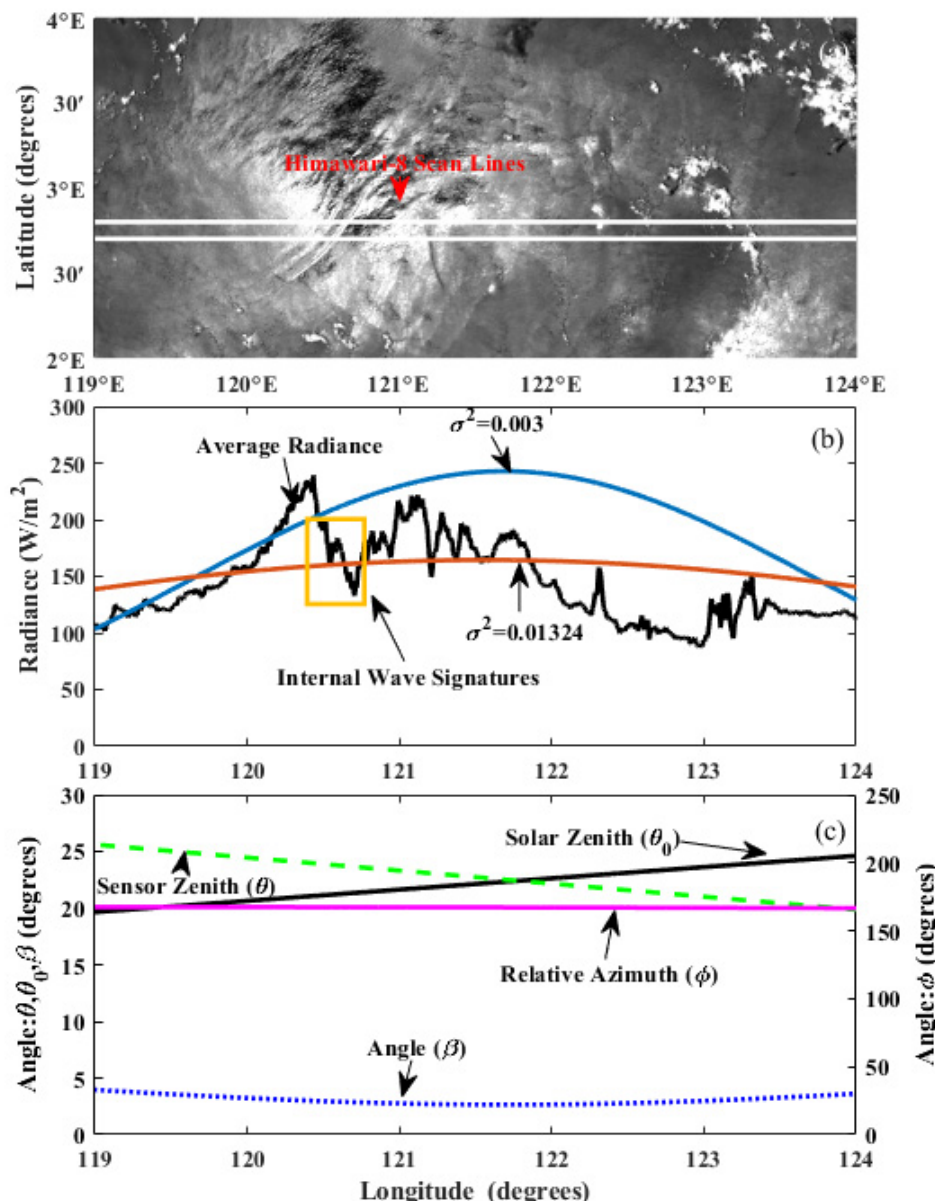
Figure 9. Analysis of the image acquired on 21 September 2020 at 05:10 UTC. ( a ) shows part of the Himawari-8 image of the Celebes Sea acquired on 21 September 2020 at 05:10 UTC, and the white solid line is the scan line of the AHI sensor onboard the Himawari-8 satellite; ( b ) shows curves of the normalized solar radiance calculated with roughness variance ( σ 2 ) values of 0.003 and 0.01324 and the average measured radiance along the scan line, and the yellow box marks the position of the internal solitary waves. The blue and orange curves indicate the radiance information of the sea surface background and internal solitary waves, respectively; ( c ) shows the changes in the solar zenith angle ( θ 0 ), sensor zenith angle ( θ ), relative azimuth angle ( φ ), and surface facet tilt ( β ) along the AHI sensor scan line. The solid black line indicates the change in the solar zenith angle ( θ 0 ) along the scan line. The green dashed line indicates the change in the sensor zenith angle ( θ ) along the scan line. The purple solid line indicates the relative azimuth angle ( φ ) along the scan line. The blue dotted line indicates the change in surface facet tilt ( β ) along the scan